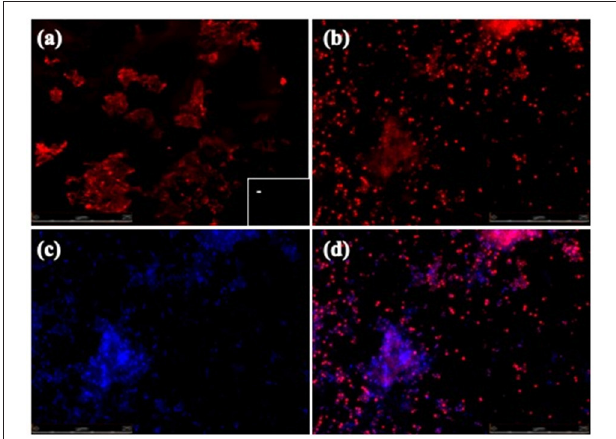
FIGURE 4 | FISH of A. pleuropneumoniae in biofilms detected in situ at drinkers in swine farms. (a–d) Epifluorescence microscopy pictures (seen at 60 × ). (a) A. pleuropneumoniae 1-4074 and in the box in the lower right corner (–) specific control ( E. coli ATCC 25922). (b) A. pleuropneumoniae positive samples from drinkers. (c) General DAPI staining of microorganisms in the sample. (d) Merge of (b,c) .